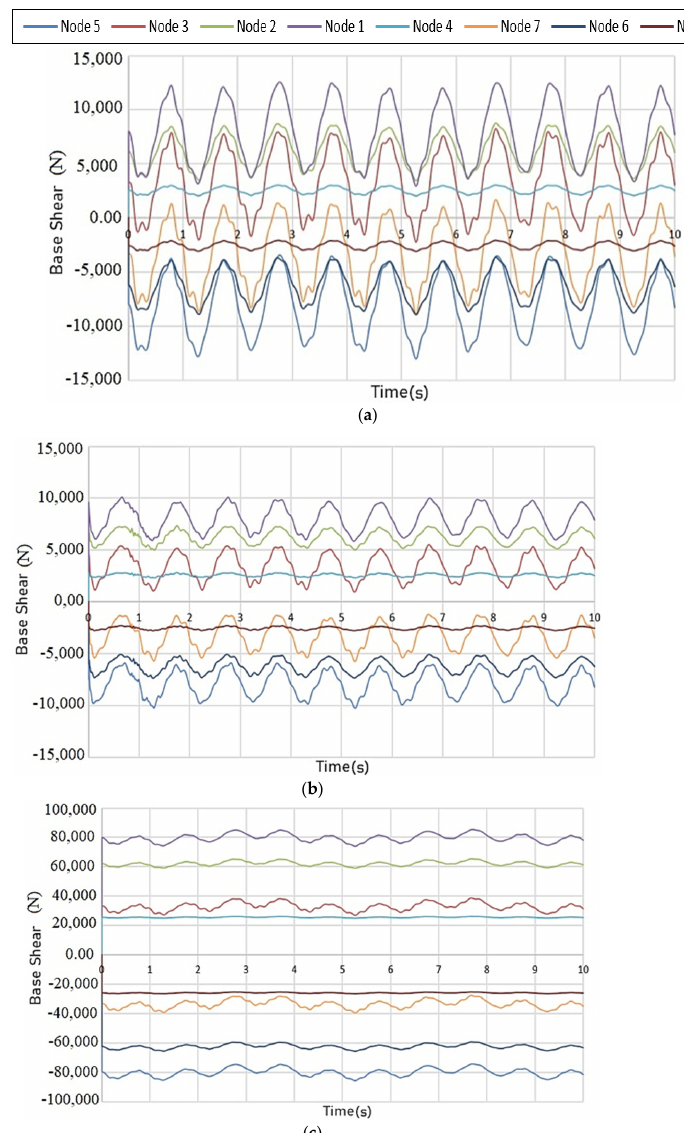
Figure 15. Base shear force in 8 supports of rigid elevated storage tank. ( a ) Base shear (no baffle); ( b ) base shear (horizontal baffle); ( c ) base shear (annular baffle).